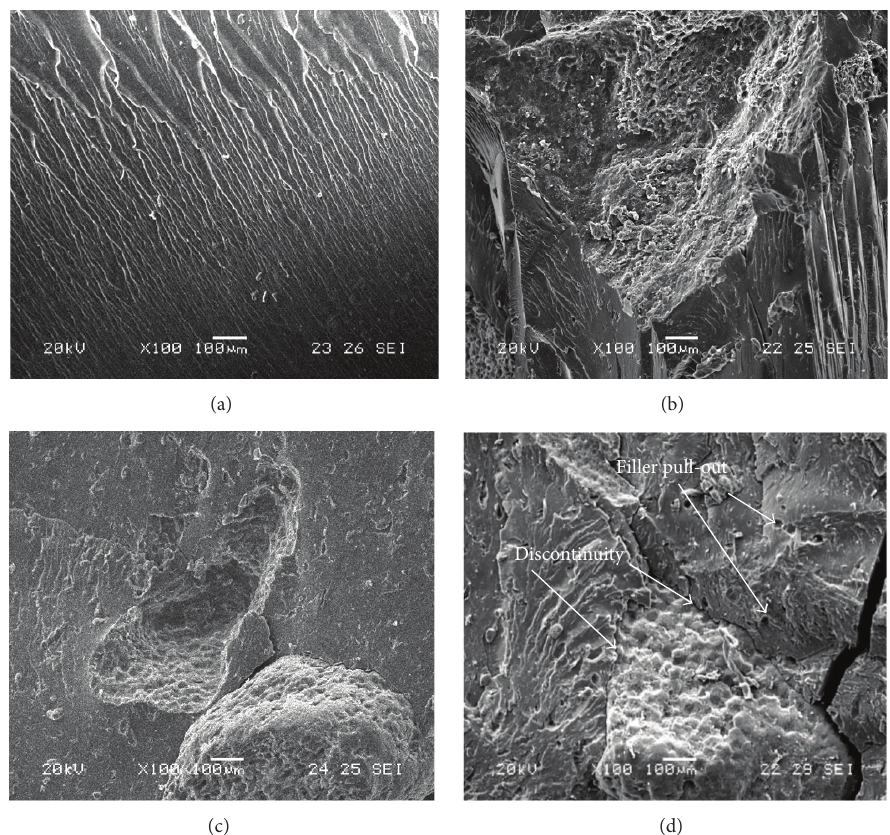
Figure 5: SEM at 1000x magnification of tensile fracture surface of UPE/OPS composites: (a) 0vol% OPS; (b) 10vol% OPS; (c) 20 vol% OPS; and (d) 30 vol%